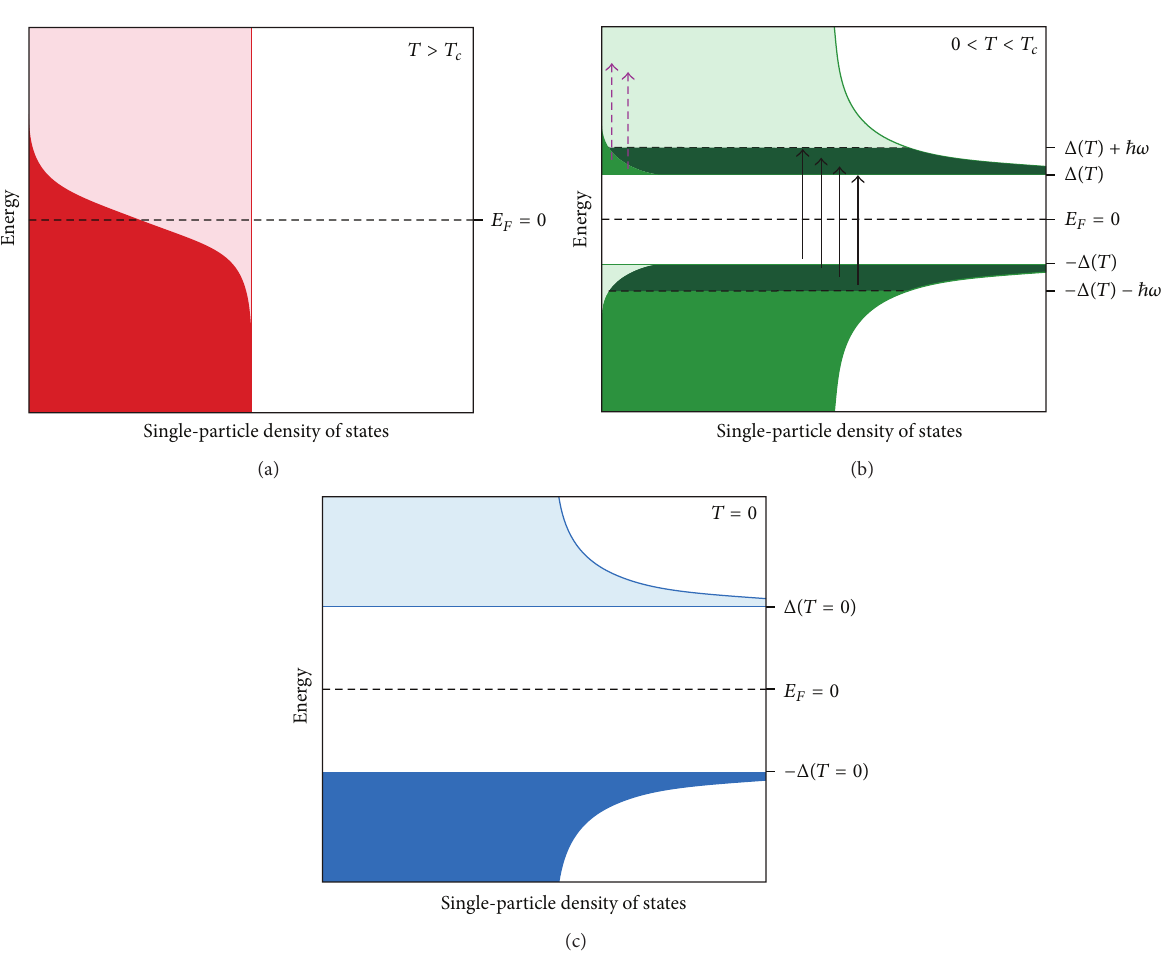
Figure 3: The density of electronic states in the close vicinity of the Fermi energy 𝐸 𝐹 . (a) For a normal metal, the density of states is basically constant. The dark colored area indicates the occupied states according to the Fermi-Dirac statistic at finite temperature. (b) In the case of a superconductor, an energy gap opens around 𝐸 𝐹 ; it grows continuously as the temperature is reduced below 𝑇 𝑐 . The dotted arrow indicates possibleexcitationsoftheoccupiedstatesabovethegap[firsttermin(1)],leadingtoaquasiparticlepeakat 𝜔 = 0 .Fortheelectronicexcitations shown by the solid arrow, a minimum energy of 2Δ is required; their contribution is captured by the second term in (1). The dark shaded area up to |Δ(𝑇) + ℏ𝜔| indicates states that can contribute to the conductivity by absorption of photons of arbitrary energy ℏ𝜔 . (c) The full size of the superconducting energy gap is given by 2Δ 0 for 𝑇 = 0 . No quasiparticle peak is present, leading to absorption only above 𝜔 𝑔 = 2Δ/ℏ . The states removed from the gap area are pilled up below and above the gap, leading to a 𝐸/√𝐸 2 − Δ 2 0